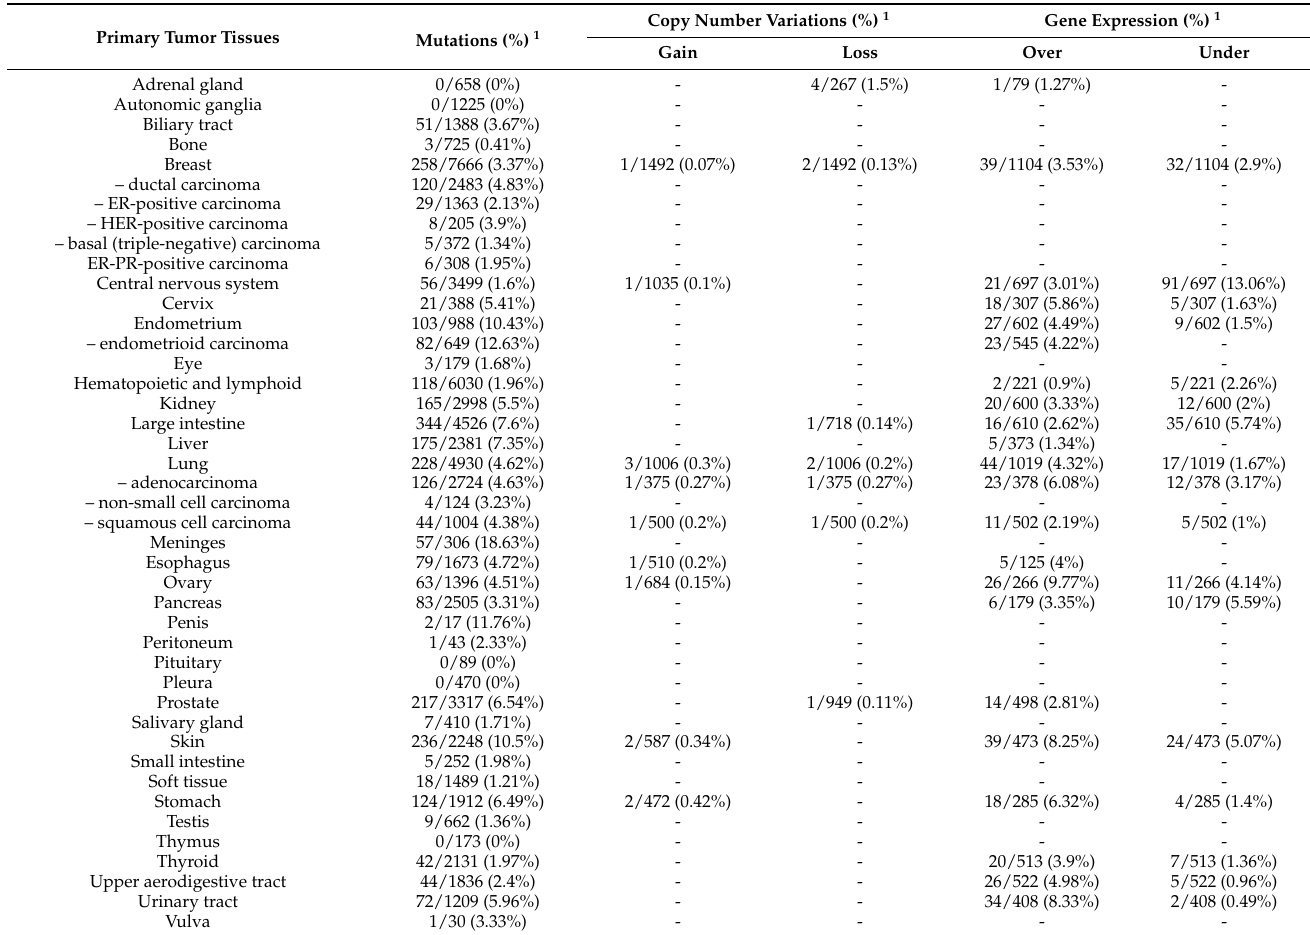
Table 5. Genetic alterations of MTOR in human